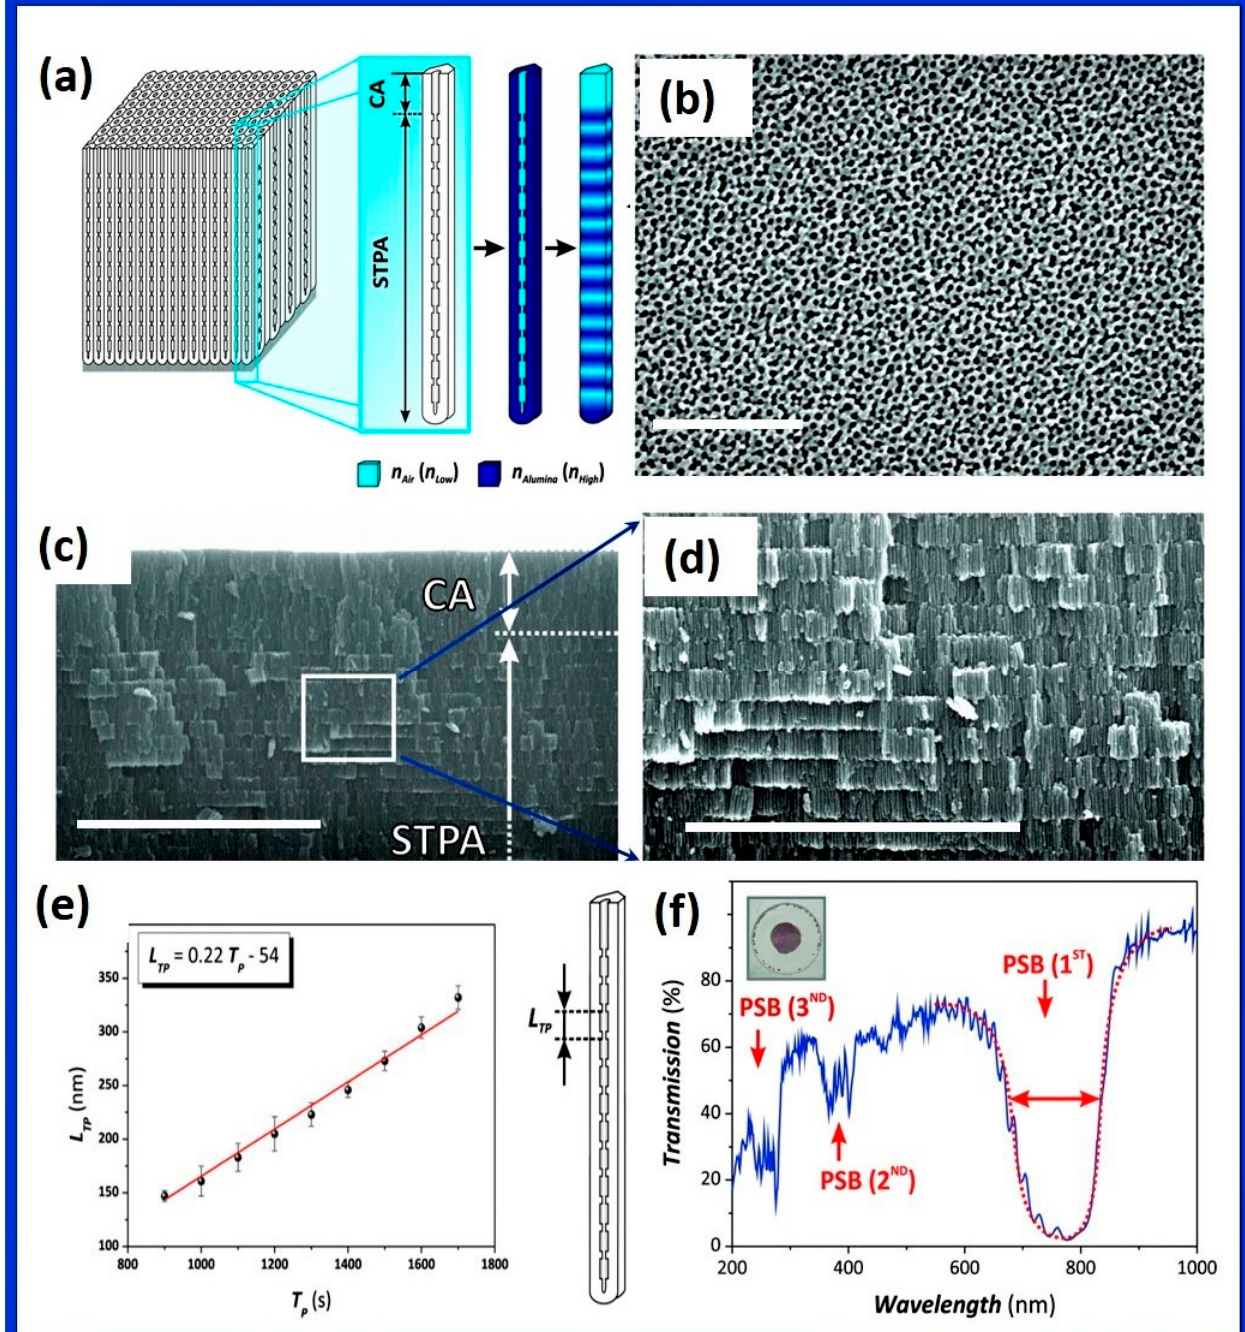
Figure 11. NAA distributed Bragg Reflectors (NAA-DBR): ( a ) the conceptual illustration depicting the diameter modulated nanopores and the distribution of high and low refractive indices ( n Alumina = n High ~1.7 and n Air = n Low ~1.0). CA—Constant current anodization. STPA—stepwise pulse anodization. ( b ) top-view and ( c ) cross-sectional SEM images of an NAA-DBR; ( d ) a magnified view of the blue square area shown in ( c ); ( e ) linear relation between the length period (L TP ) and anodization period (T P ) along with the schematic definition of L TP ; ( f ) a representative transmission spectrum showing the photonic stop bands (PSB) from NAA-DBR. Reproduced with permission from Cheryl Suwen Law, Siew Yee Lim, and Abel Santos, Scientific reports 8 (1), 1 (2018). Creative Commons License: http://creativecommons.org/licenses/by/4.0/ (accessed on 31/12/2021) [279] .